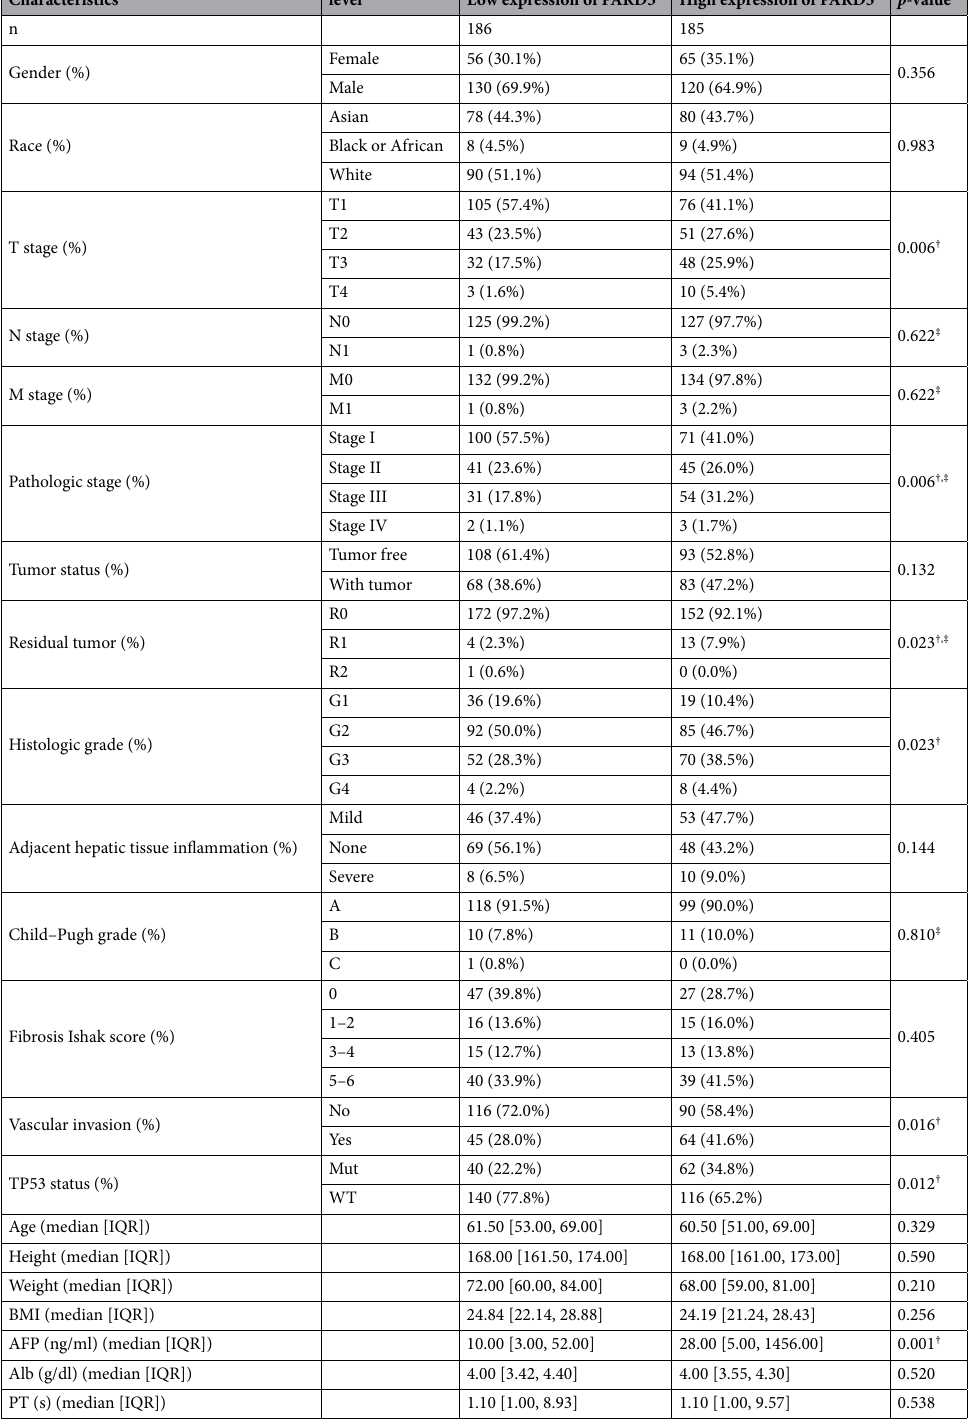
Table 1. Clinicopathologic characteristics in LIHC cohort according to PARD3 expression. Mut mutant, WT wild type, BMI body mass index, AFP alpha fetoprotein, Alp albumin, TB total bilirubin, PT prothrombin time. † Statistically significant. ‡ Fisher exact